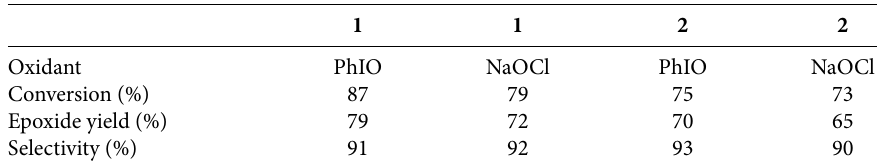
Table 4. Catalytic epoxidation results of complexes 1 and 2